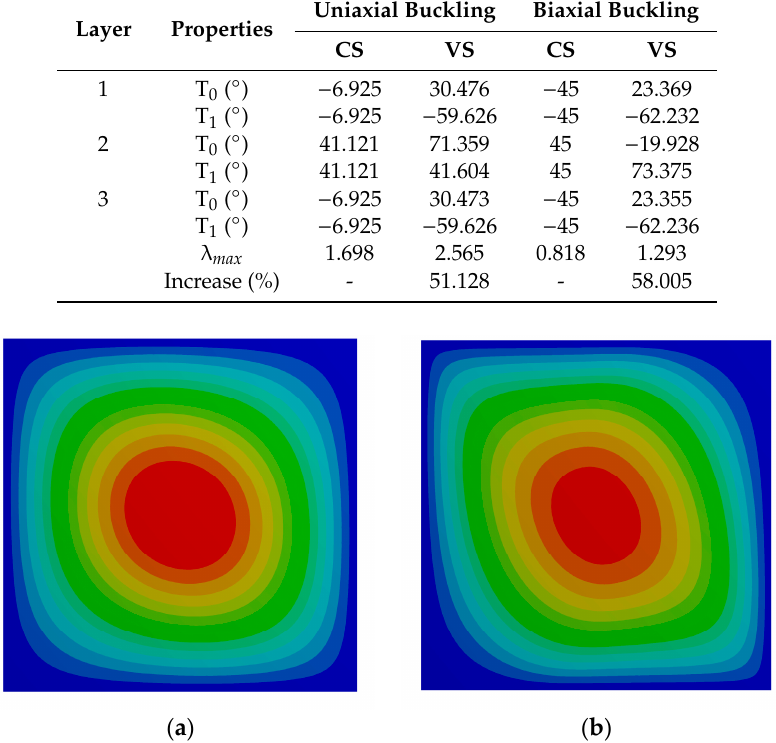
Figure 7. Critical buckling mode shape for the optimal layups for the SSSS plate. ( a ) CS and ( b ) VS uniaxial buckling.